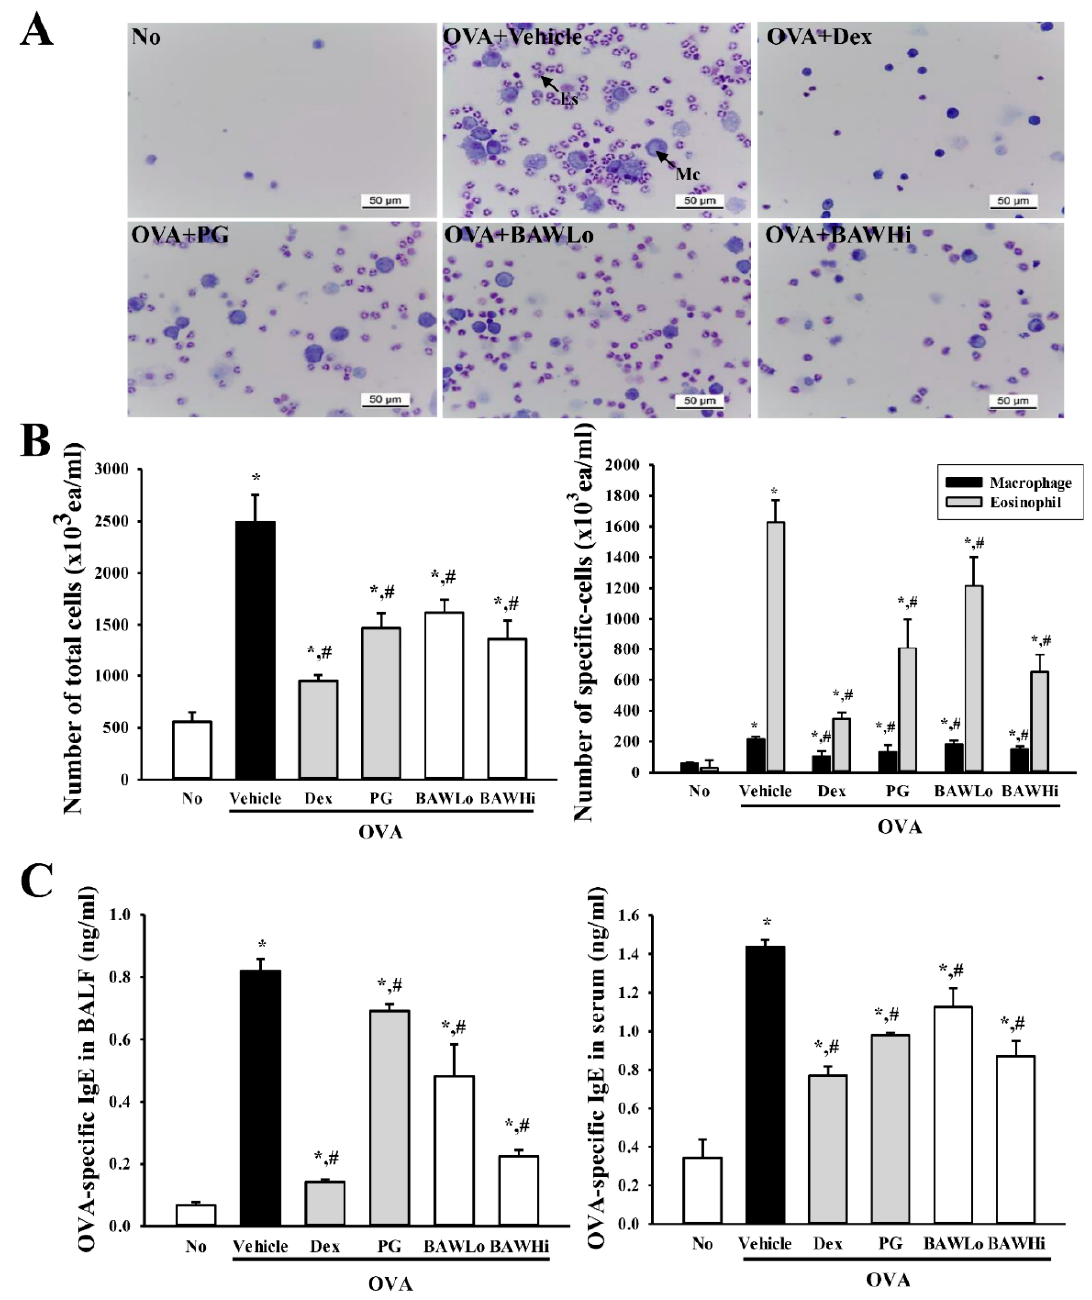
Figure 3. Suppression effects of BAW on the influx of inflammatory cells and IgE concentration in BALF. ( A ) Total cells were collected from the BALF of lungs using centrifugation and measured repeatedly. These cells were then suspended in PBS and applied to a slide by cytospinning, stained with May–Giemsa solution, and observed under a light microscope at 400 × magnification. ( B ) The number of total cells, eosinophils, and macrophages was determined by counting within a 1 mm 2 area. ( C ) The concentration of OVA-specific IgE was quantified in BALF and serum using an enzyme-linked immunosorbent assay with a minimum detectable concentration of 20.7 pg/mL. Es, Eosinophil; Mc, Macrophage. The data shown represents the means ± SD ( n = 8). * indicates p < 0.05 compared to the No-treated group. # indicates p < 0.05 compared to the OVA + Vehicle treated group.